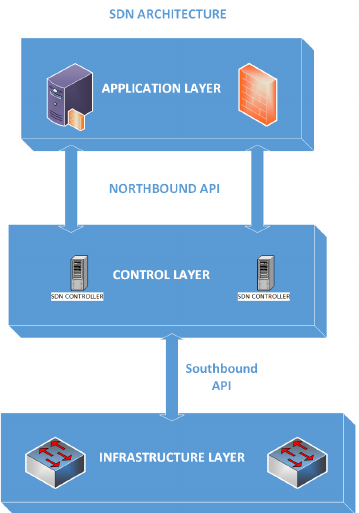
Figure 1. SDN implementation architecture.